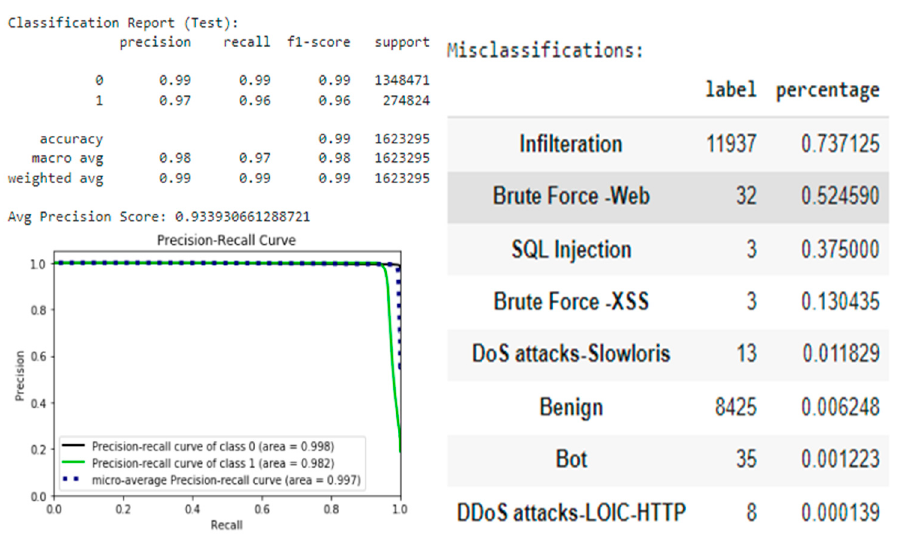
13 of 29 Table 2. Model selection.